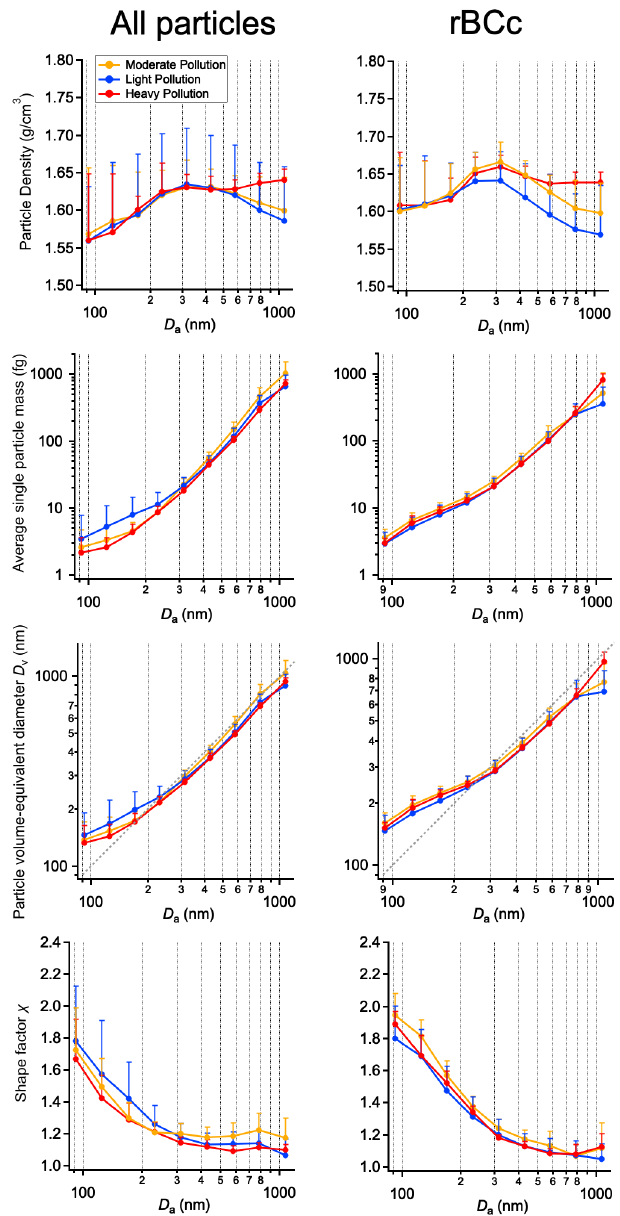
Figure 6. The particle density, average single-particle mass, shape factor and volume-equivalent diameter for all particles (all particles, left) and refractory-black-carbon-containing particles (rBCc, right) under different pollution